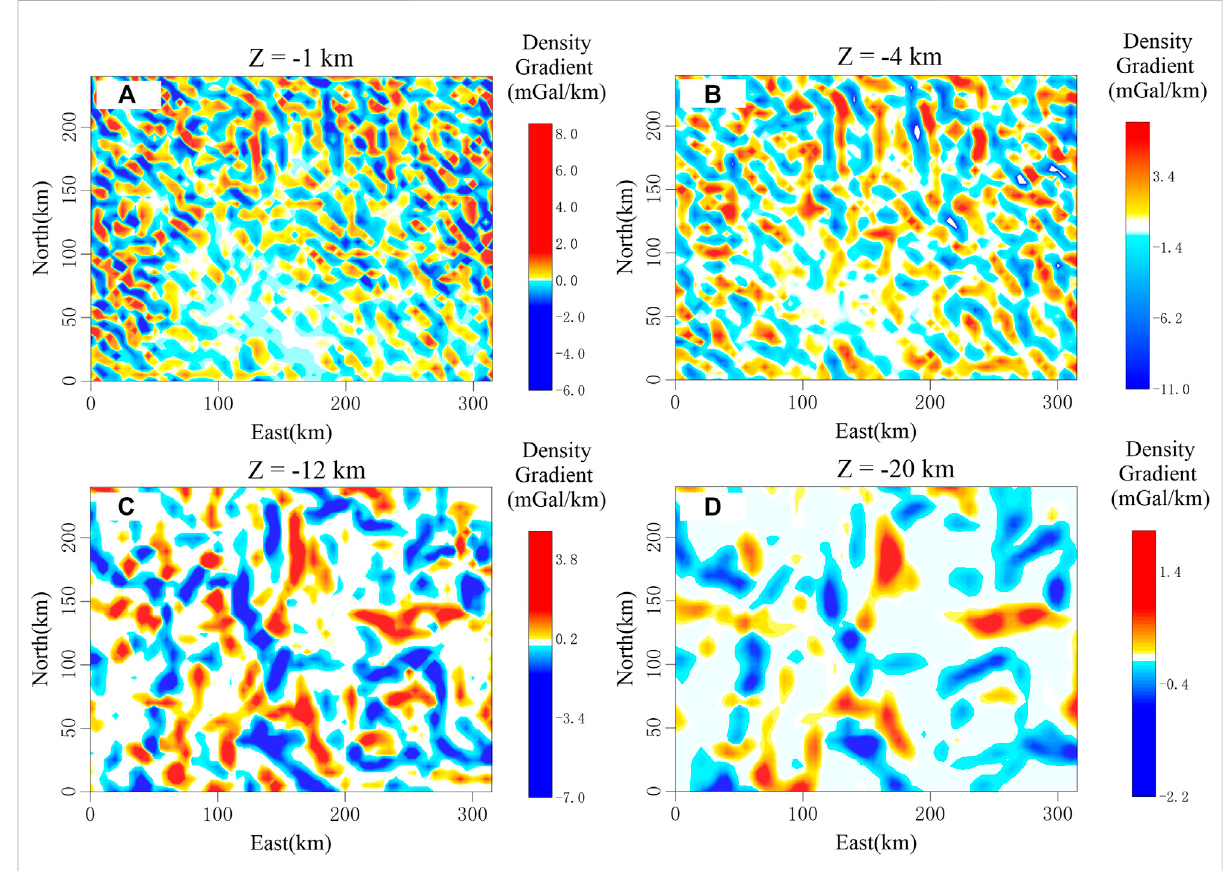
FIGURE 11 Horizontal slices of 3D focusing density gradient inversion results for different vertical